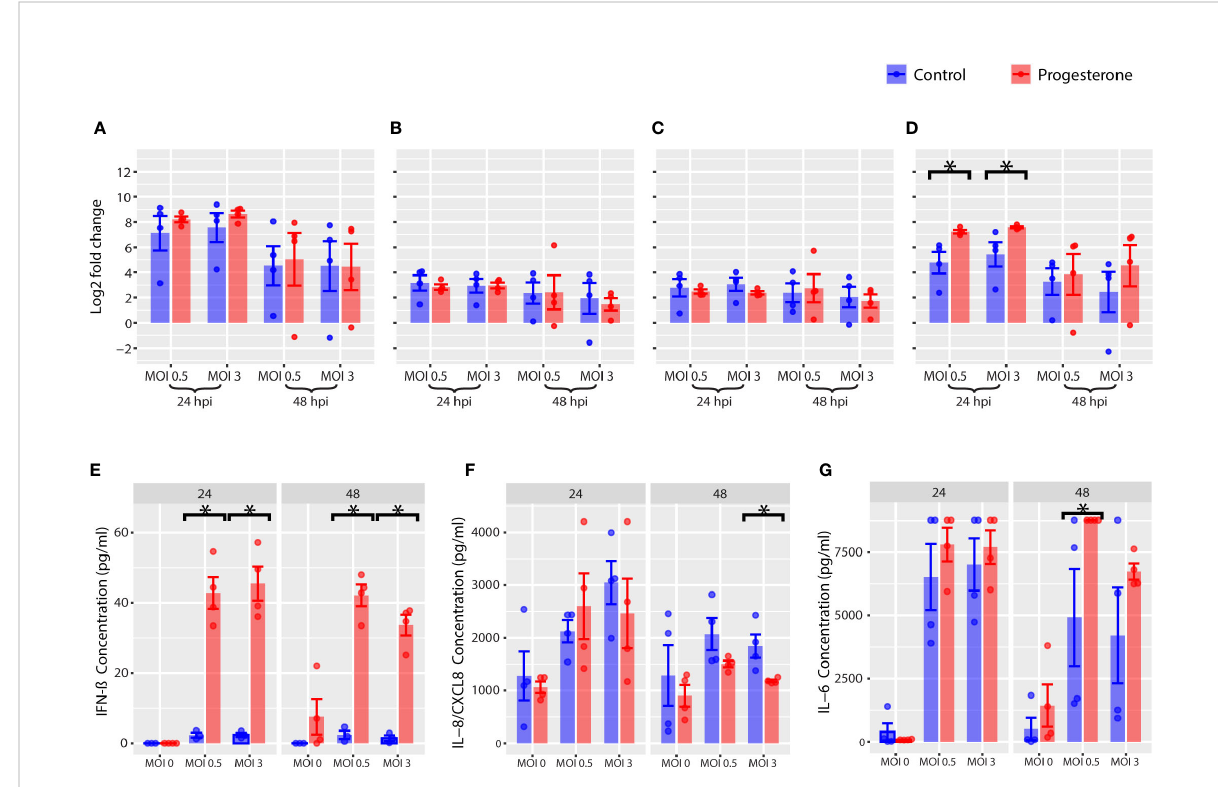
FIGURE 2 Innate immune response in Calu-3, a lung cell line. Innate immune gene expression was measured by RT-qPCR. The gene expression log2 fold change is reported for IFNB (A) , IFIT1 (B) , MXA (C) , and IL6 (D) . The protein concentration of cytokines in the supernatant were measured with Luminex and are reported for IFN- b (E) , IL-8 (F) , IL-6 (G) . *p-value was less than 0.05, as determined by the statistical analysis detailed in the Methods